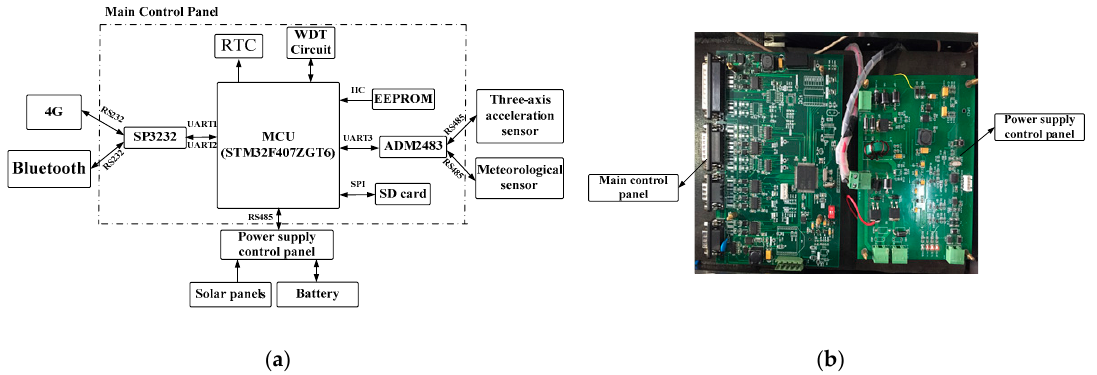
Figure 14. Monitoring device: ( a ) principle diagram of the monitoring device, RTC(Real-Time Clock),WDT(Watchdog Timer); ( b ) main control and power supply control panels.